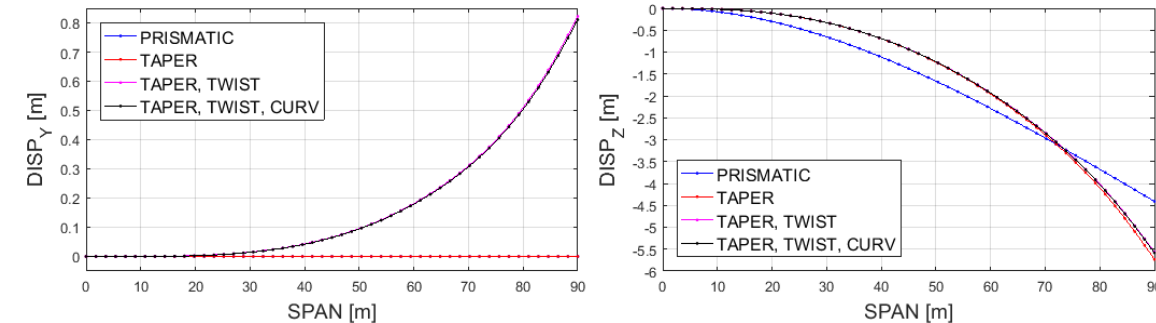
Figure 11. Centre-line points displacement of prismatic case (blue) and non-prismatic cases (other colours) for F = 250kN.